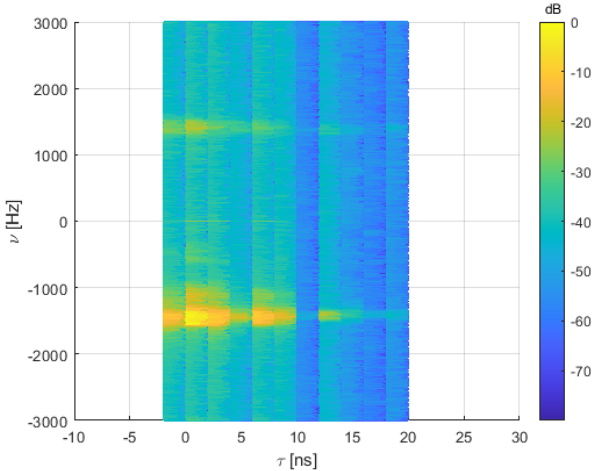
Figure 23. Delay-Doppler spectra from the highway campaign without aligning the main contribution.